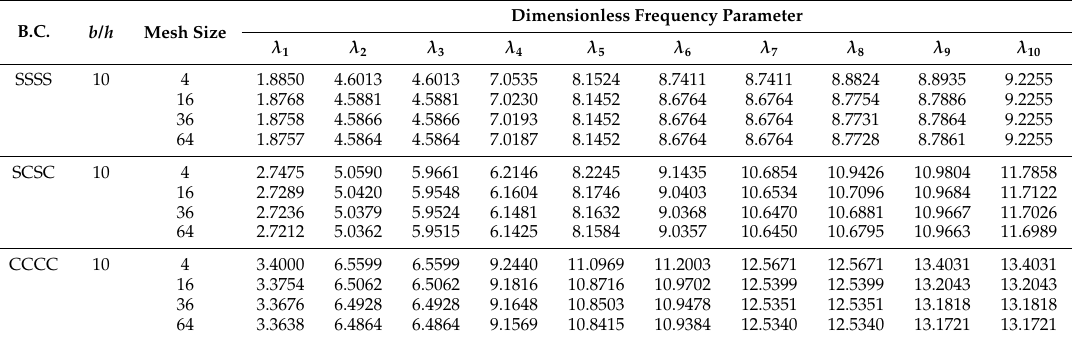
Table 1. Convergence of dimensionless frequency parameter for square plates of ratio b / h =